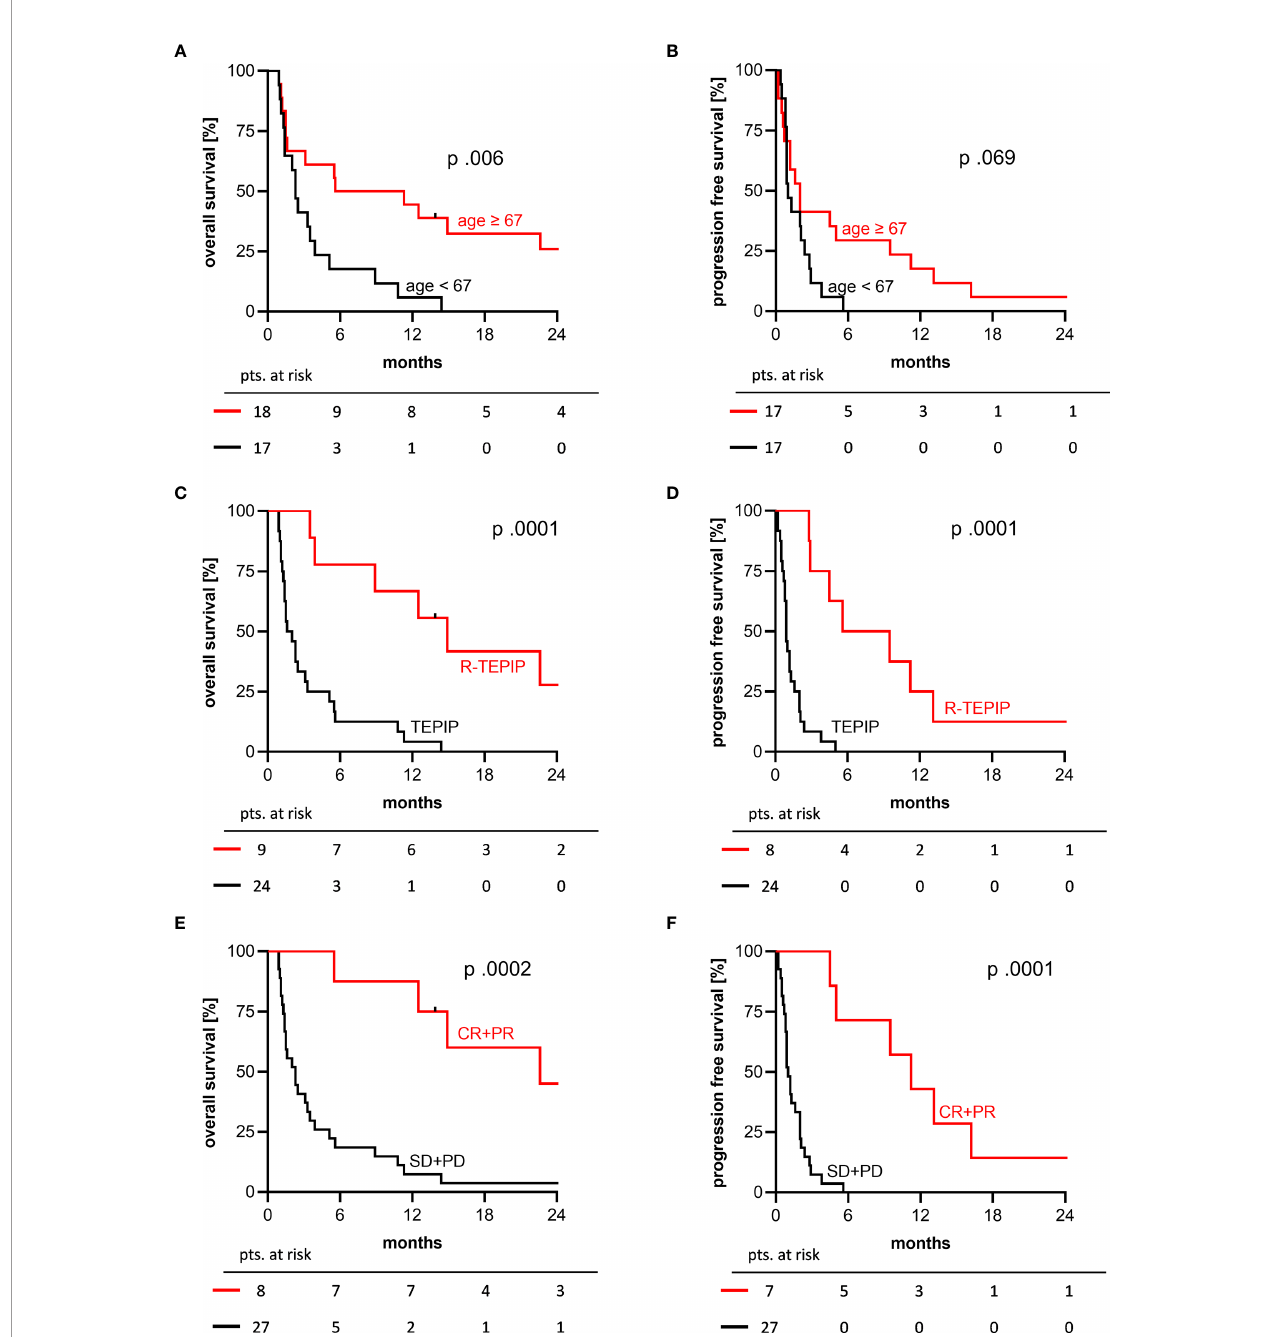
FIGURE 3 | 2-years OS and PFS Kaplan-Meier curves by selected patient characteristics. (A, B) older (red) versus younger (black) half of the study cohort, median age 67 years; (C, D) combination with rituximab (red) versus TEPIP alone (black); (E, F) responding (red) versus not responding patients (black). p values were determined by log-rank